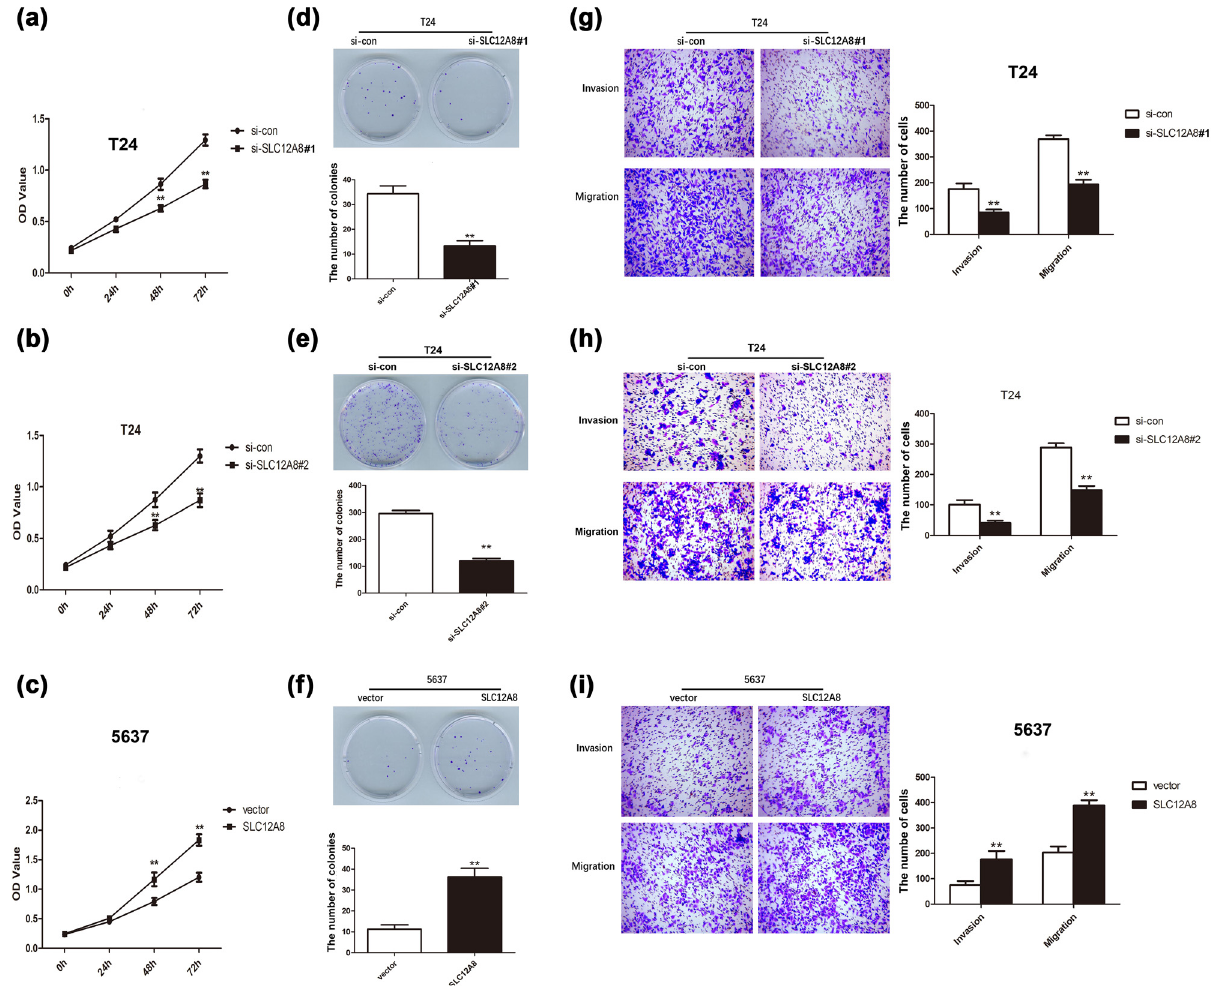
Figure 3: SLC12A8 knockdown or upregulation a ff ected the growth of bladder cancer cells. ( a ) The proliferation of T24 cells with down - regulated SLC12A8 detected by CCK8, ** p < 0.01. ( b ) The proliferation of T24 cells was examined by CCK8 after knockdown of SLC12A8 by si - SLC12A8#2, ** p < 0.01. ( c ) The proliferation of 5,637 cells with upregulation of SLC12A8 detected by CCK8, ** p < 0.01. ( d ) The plate cloning experiments showed that the proliferation rate of T24 cells in the si - SLC12A8#1 group was remarkably reduced compared with the si - con group, ** p < 0.01. ( e ) Knockdown of SLC12A8 by si - SLC12A8#2 reduced the colony formation ability of T24 cells, ** p < 0.01. ( f ) The plate